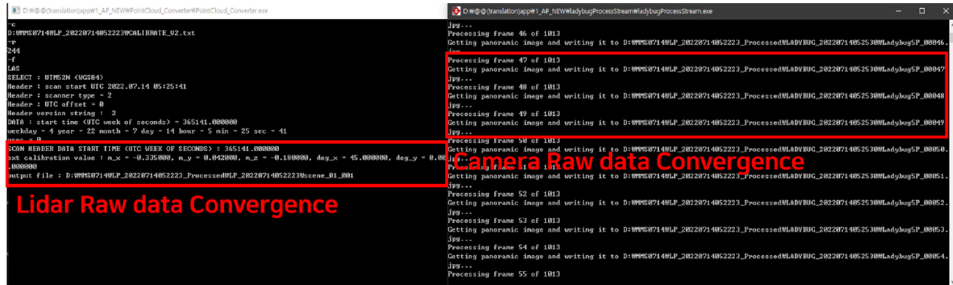
Figure 8. Example of the convergence of LIDAR raw data and camera raw data.